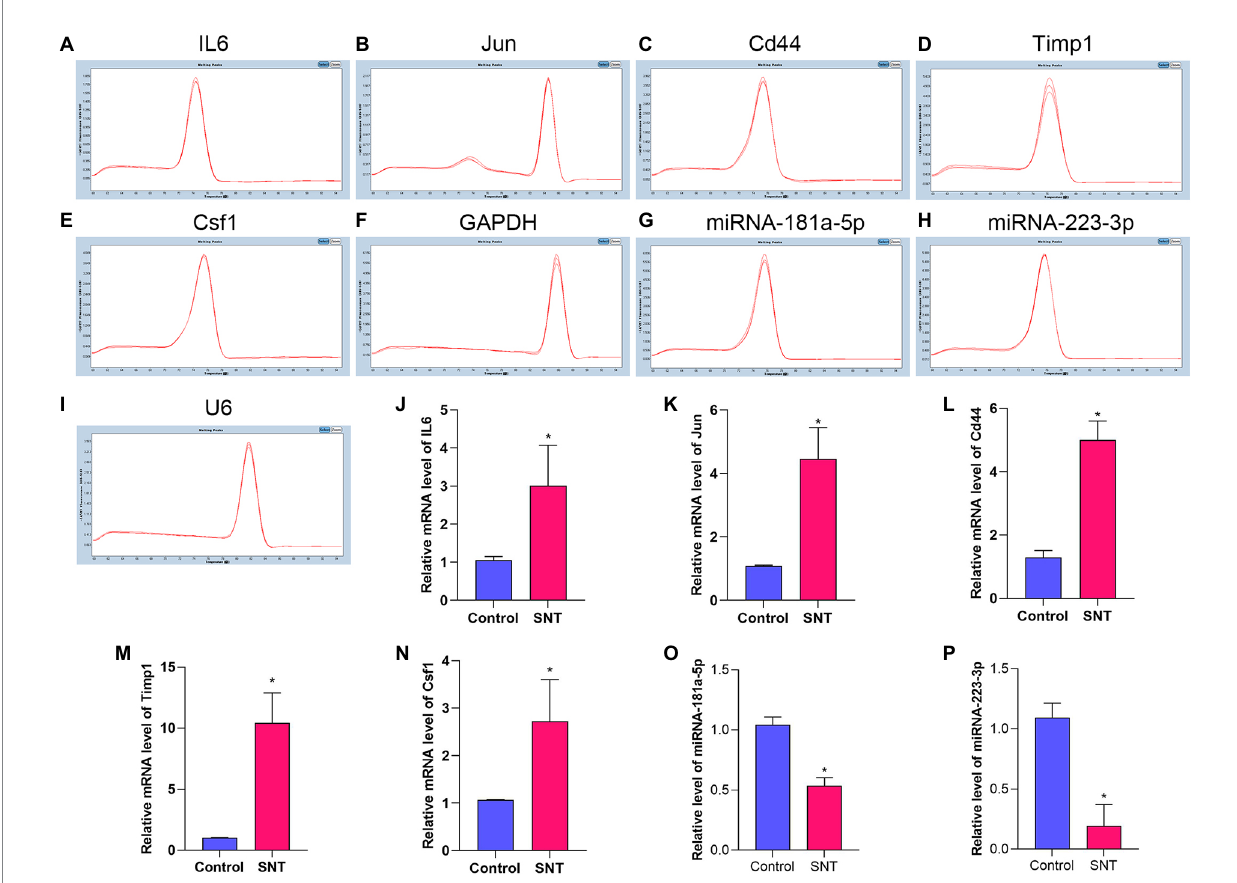
FIGURE 8 Amplification and identification of differentially expressed mRNAs and miRNAs. (A–I) The melt curves of the identified mRNAs and miRNAs. (J–P) The results of qRT-PCR show the expression levels of DEGs between the two groups. Data are presented as means ± SD ( n = 3; * p < 0.05).